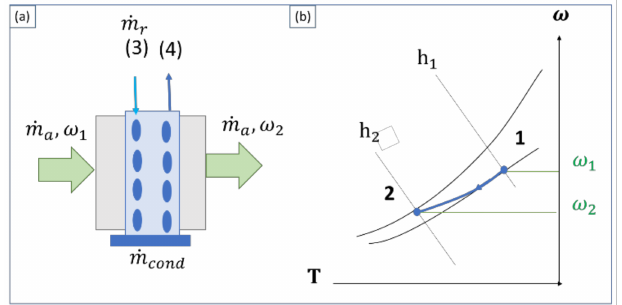
Figure 8. ( a ) Dehumidification by cooling and ( b ) psychometric diagram of the